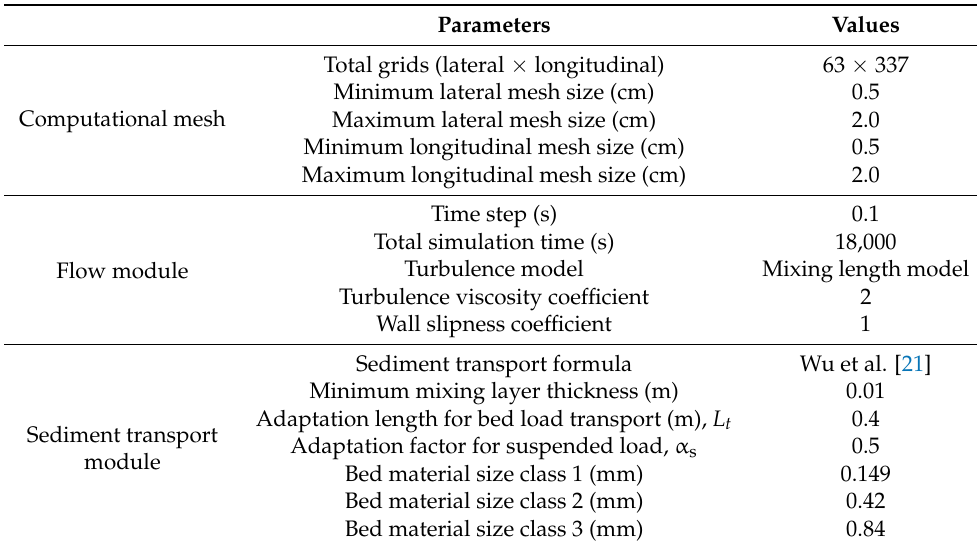
Table 2. Parameters used in model